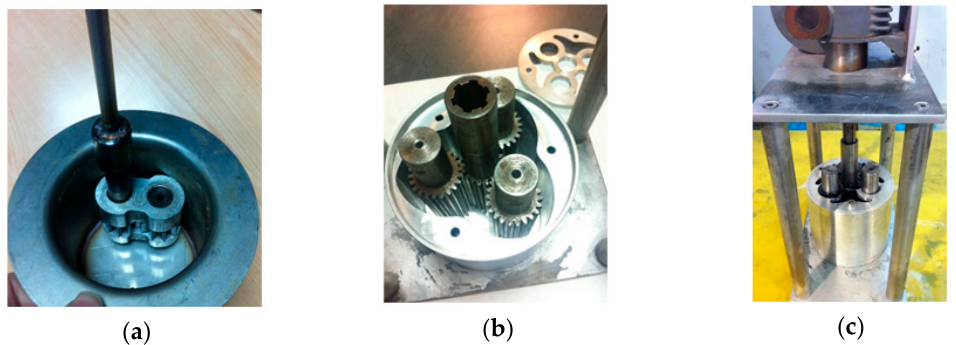
Figure 2. In house assembled gearbox miller; the two gear head is observable in ( a ) and three gear head from two different perspectives are observable in ( b ) and ( c ).